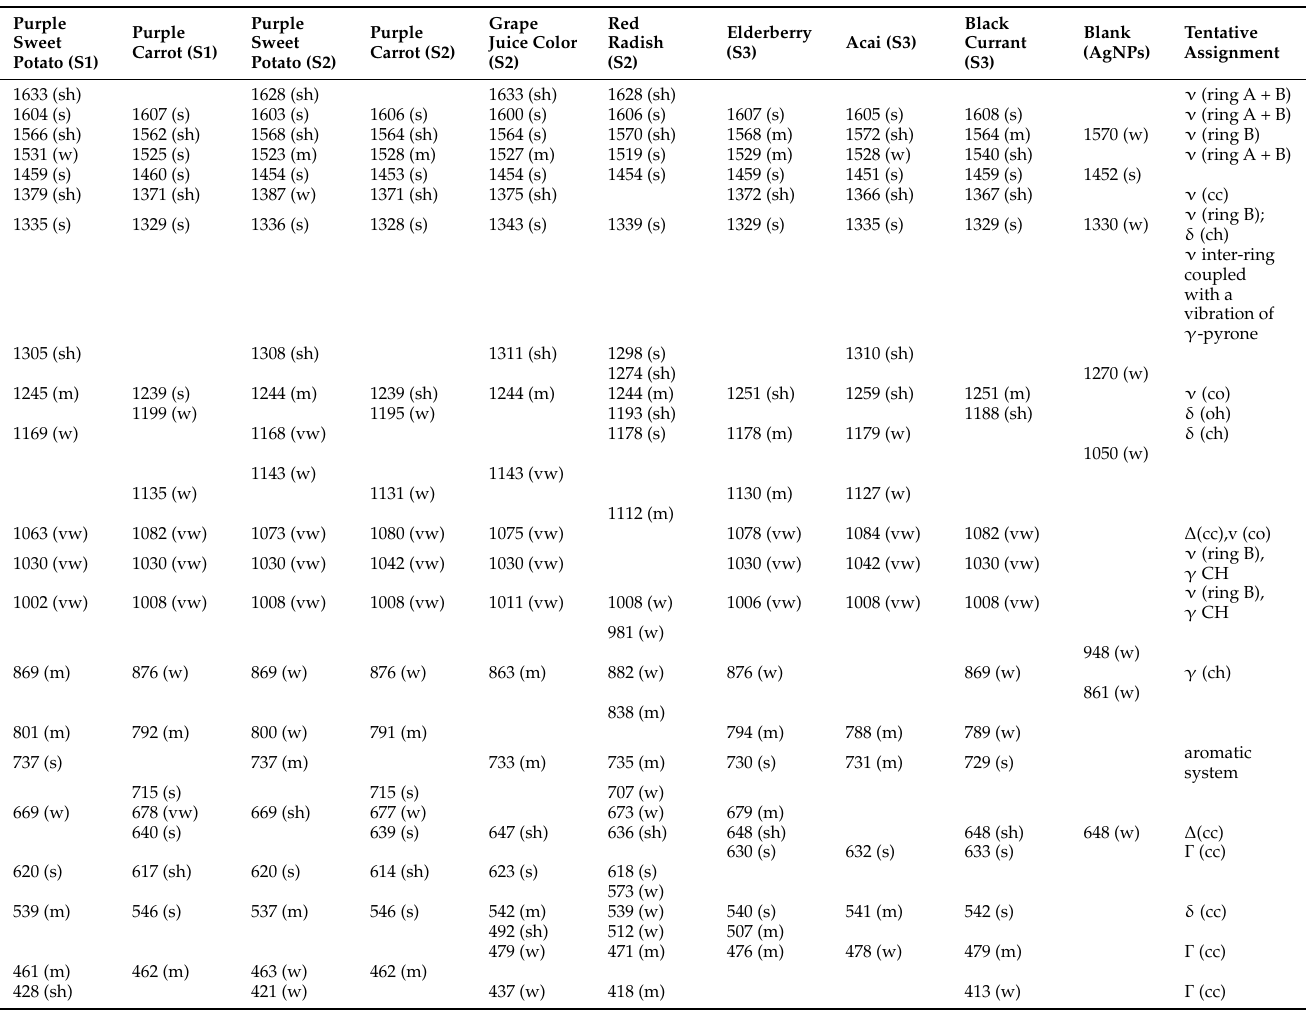
Table 3. Band wavenumbers and their tentative assignments of anthocyanin